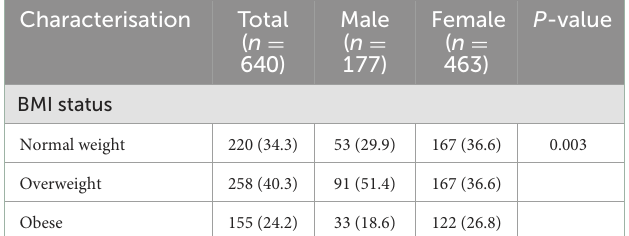
TABLE 1 Baseline characterisation of schoolteachers from public school stratified by